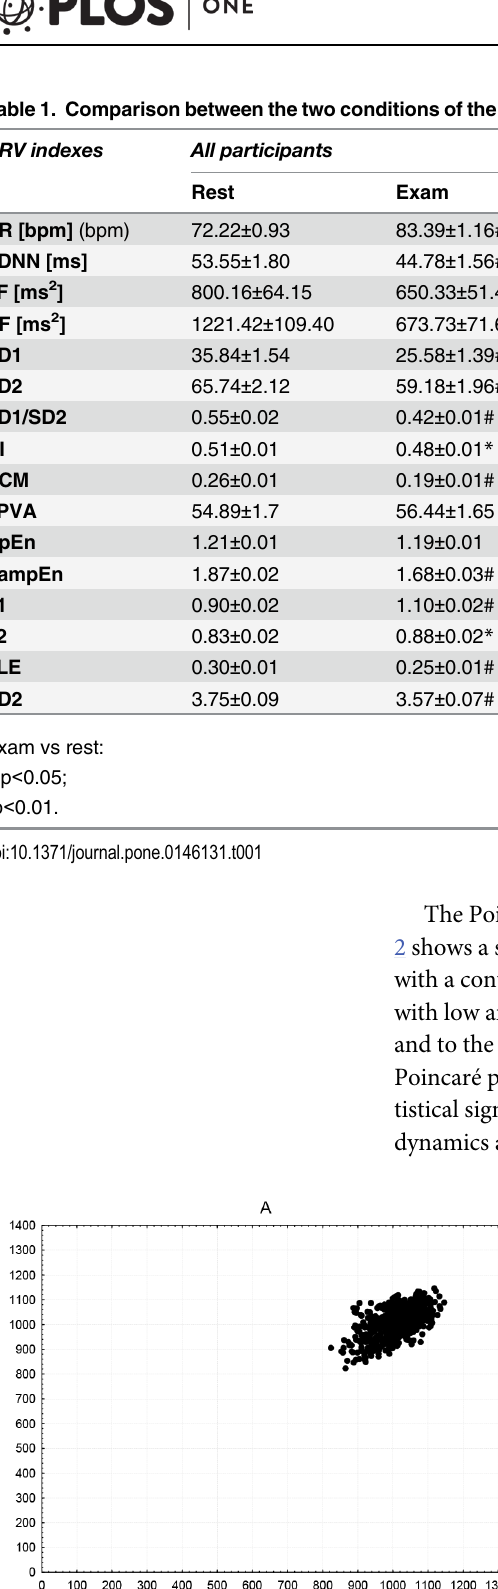
Fig 2. Poincaré plots during the rest (A) and exam sessions